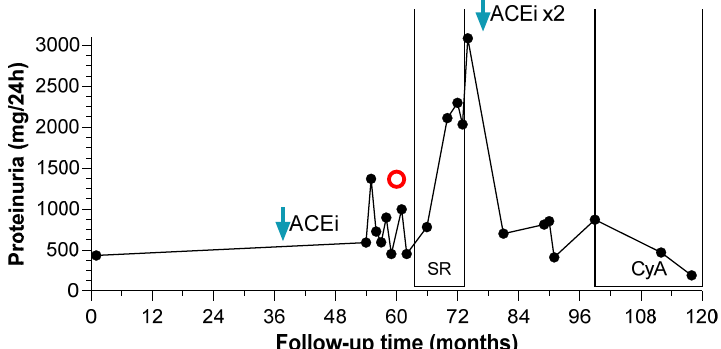
Figure 3. Proteinuria changes over time of CyA ‐ sensitive patient. Proteinuria (mg/day) is reported over time (months) since the diagnosis of MCTO disorder. Red circle corresponds to the kidney biopsy. When proteinuria exceeded 500 mg/24 h the patient started ACEi (Enalapril 5 mg daily) (blue arrow). Due to worsening of proteinuria, a kidney biopsy was performed at month 60 (red circle), with the diagnosis of focal segmental glomeruloscelrosis. The pa ‐ tient received 8 ‐ months course of oral steroids without benefit. The dose of ACEi was doubled at month 73 (blue arrow) and the proteinuria set around 600–700 mg/24 h. The patient started cyclosporine (150 mg daily) at month 98 (CyA brackets) and over 11 months the proteinuria decreased below 200 mg/24 h (190 mg/24 h at last follow ‐ up).